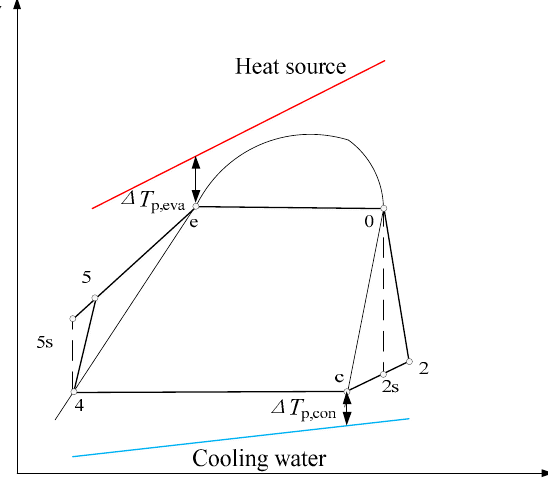
Figure 2. Typical T-s diagram of a basic ORC system.